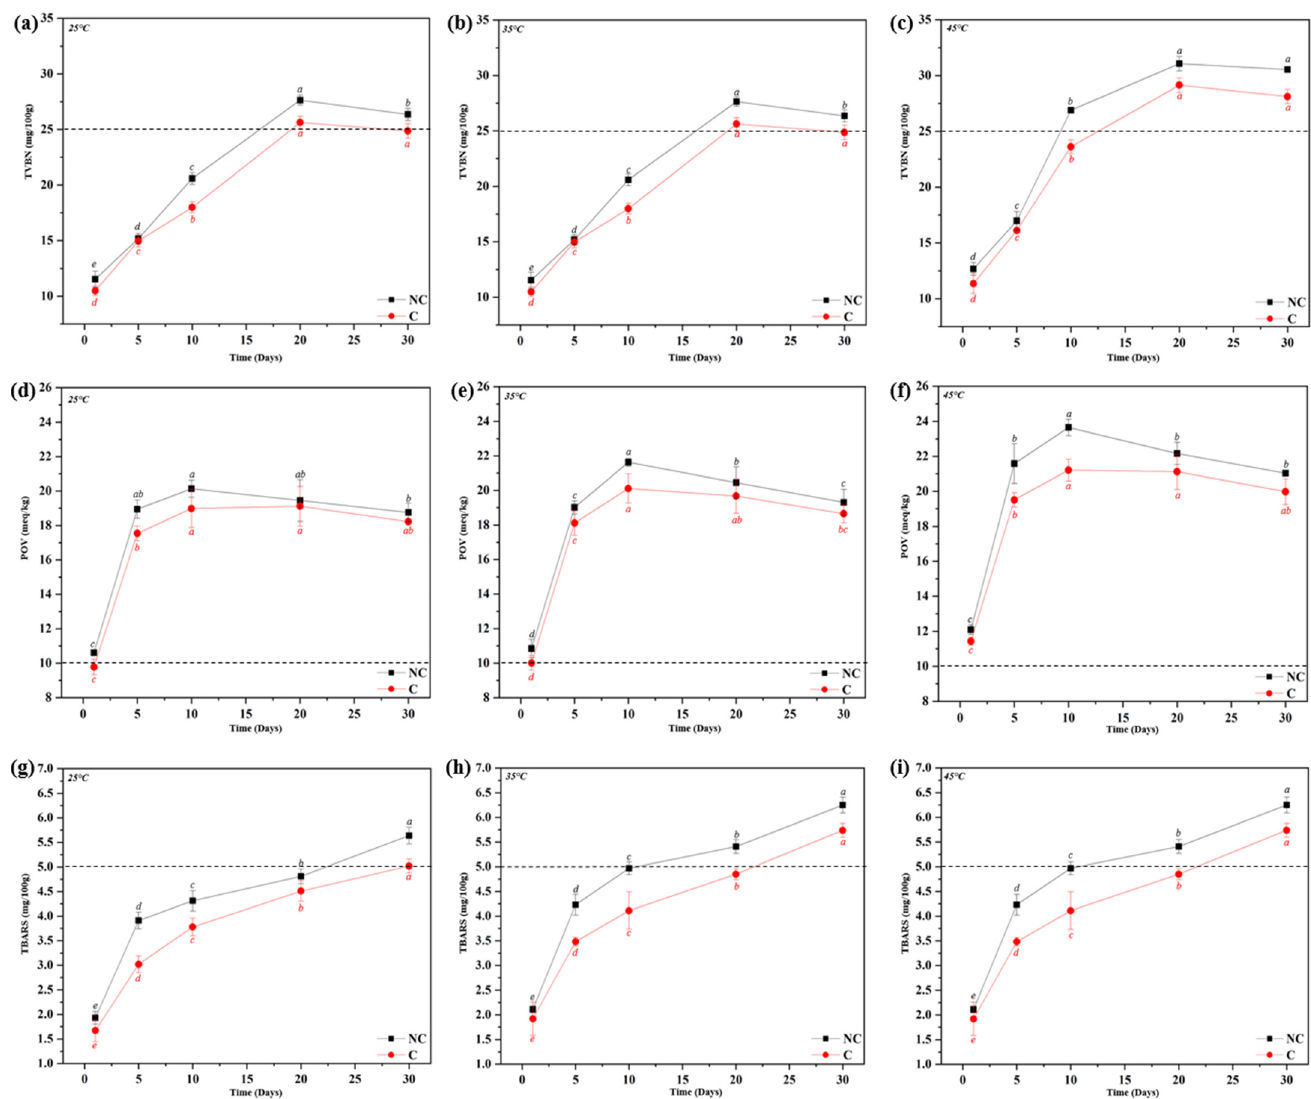
Figure 2. The levels of TVBN ( a – c ), POV ( d – f ), and TBARS ( g – i ) of BDA during storage period at 25, 35, and 45 °C, respectively. (Black dotted line indicates the acceptable range of the levels of TVBN, POV, and TBARS value). (Note: Different italic letters ( a – e ) show significantly different values ( p < 0.05) according to Duncan’s multiple range tests.)